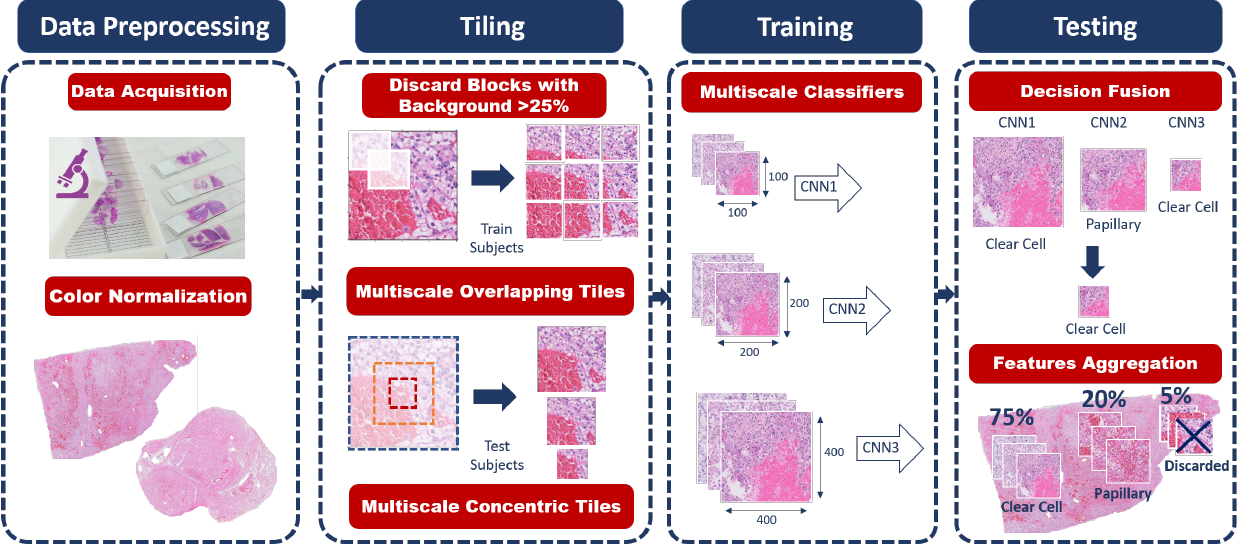
Figure 5. The proposed system pipeline. The first stage is data preprocessing, including color normalization. The second stage is tiling to divide the WSI into small patches. The third stage is training the multiple CNNs. Finally, the last stage is testing to predict the final classification